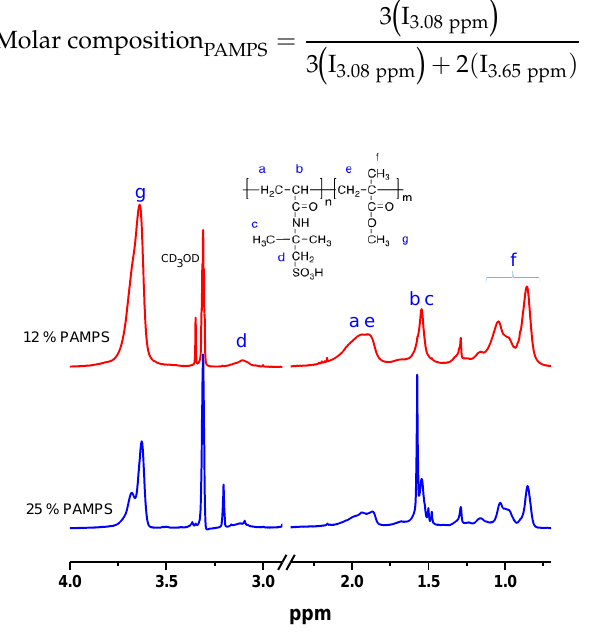
Figure 4. 1 H-NMR (CD 3 OD) of poly(2-acryloamido-2-methylpropanesulfonic acid)- b -poly(methyl methacrylate) (PAMPS- b -PMMA) with 12 and 25% mol of PAMPS.